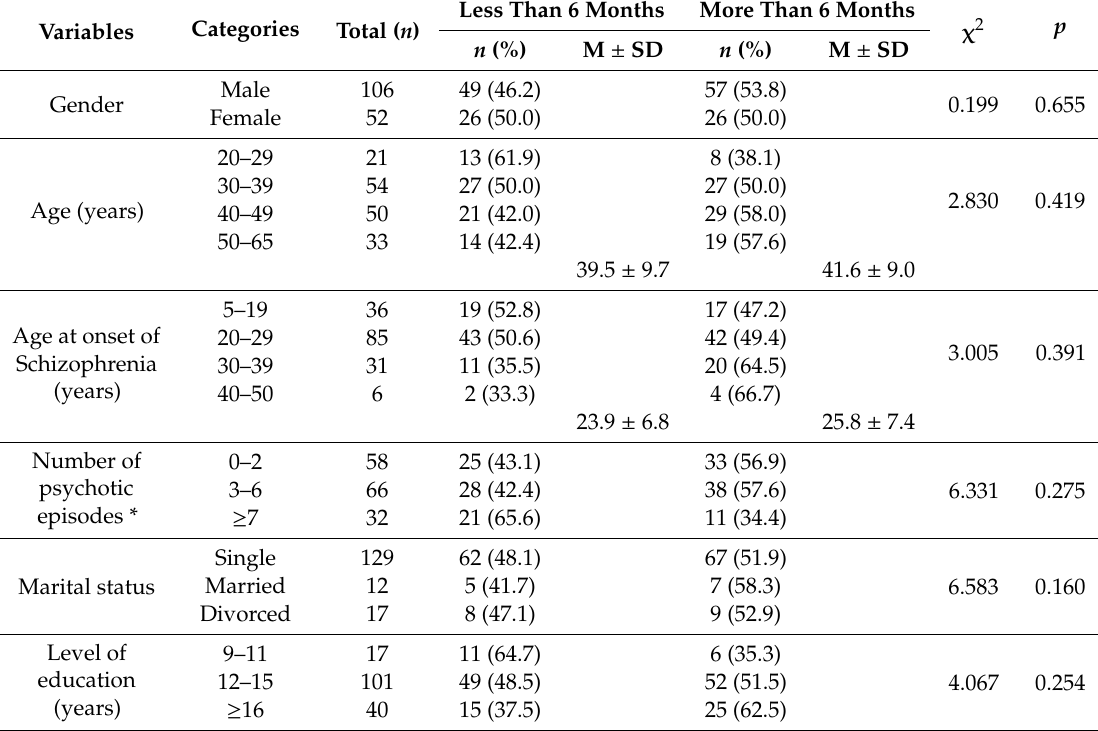
Table 1. Participants’ demographic characteristics.